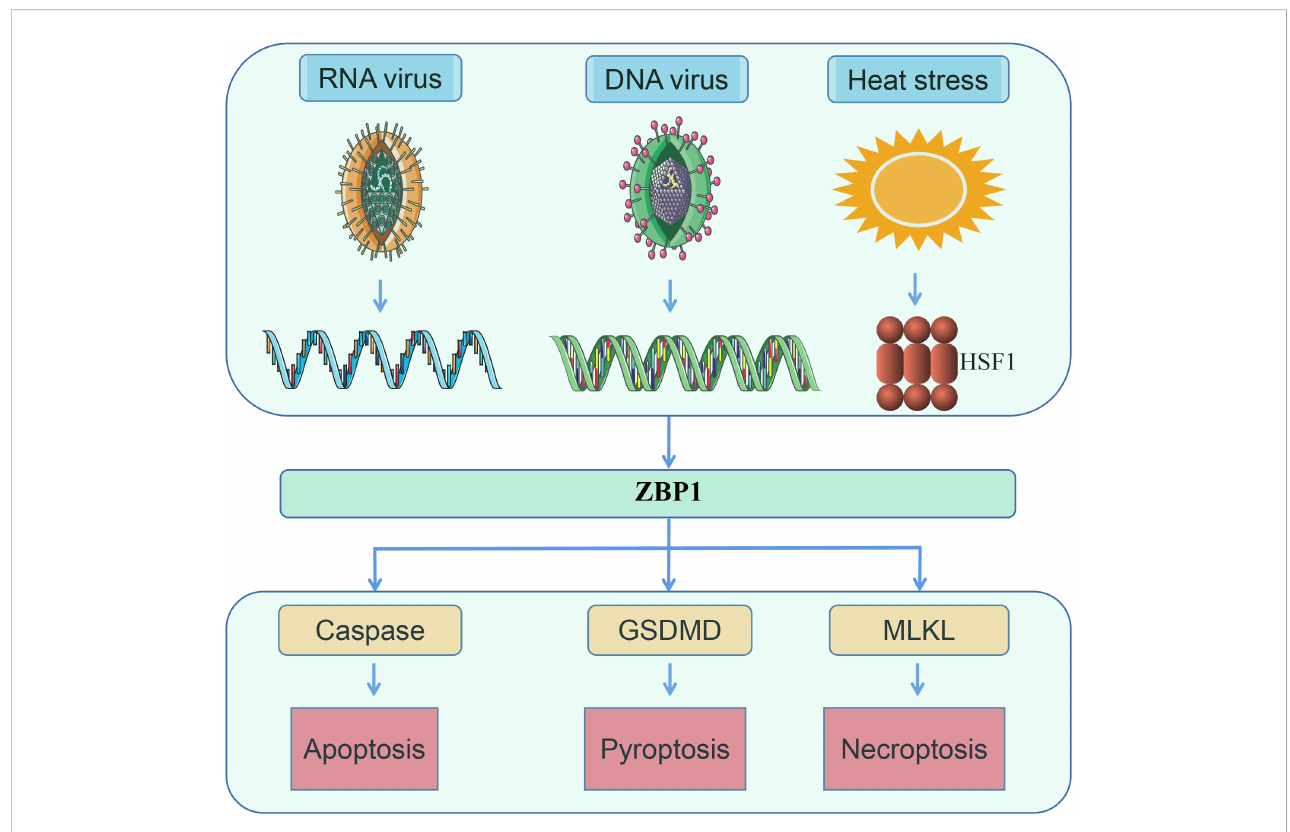
FIGURE 2 ZBP1 senses RNA virus infection, DNA virus infection, and heat stress, following which the necrotic complex will be assembled to induce apoptosis, pyroptosis, and necroptosis (14,